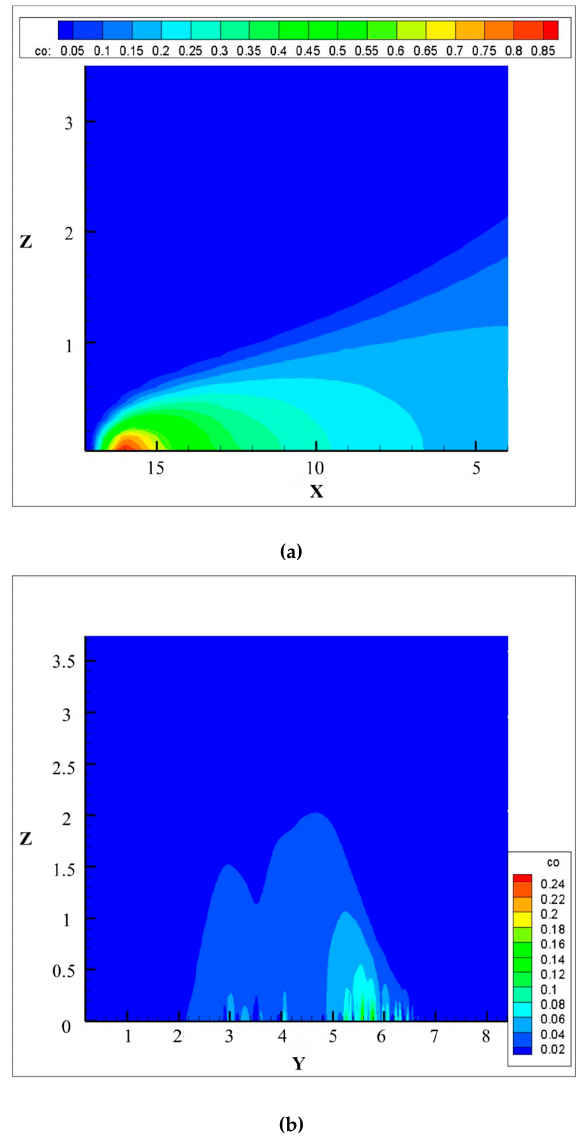
Figure 7. Contour map of carbon monoxide mass fraction at cutting surface. (a) Vertical section along the axis of the vehicle model; (b) Cross-section along the Y -axis (X = 10 m).